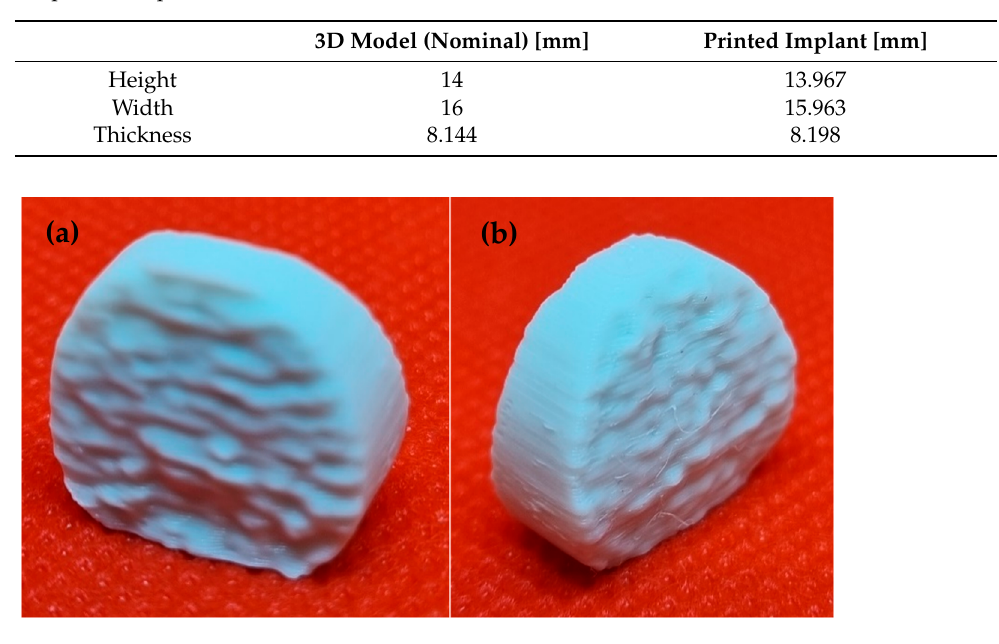
Figure 13. The implant of the intervertebral disc printed by FDM technology ( a ) Bottom side of the intervertebral disc model; ( b ) Top side of the intervertebral disc model.